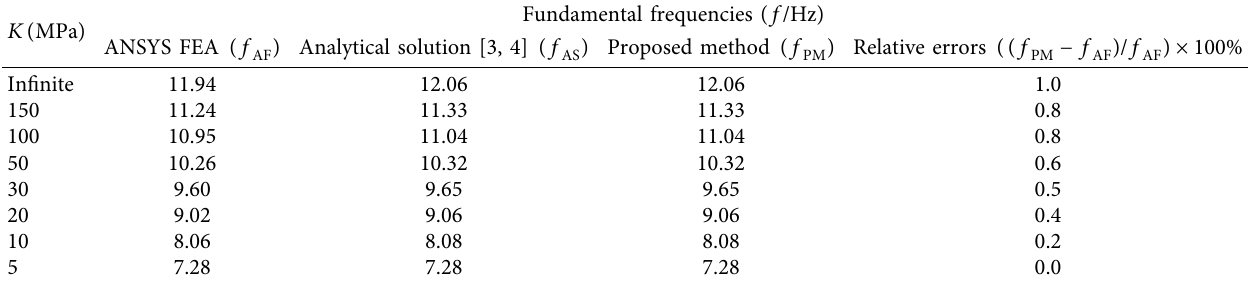
Table 2: A comparison of the fundamental frequencies for case 1. Fundamental frequencies ( f /Hz) K ( MPa )